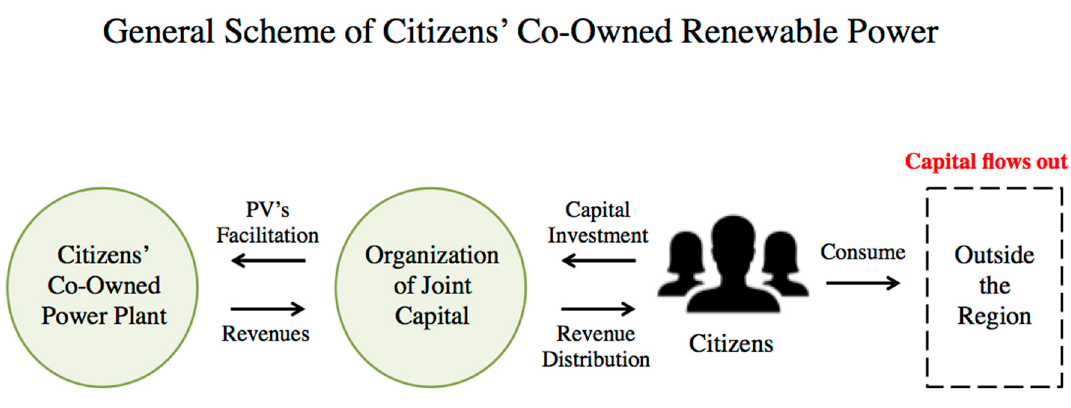
Figure 3. One possible weakness of the general Citizens’ Co-Owned Power Plants: “capital flows out of the region”. Source: modified from Hashimoto and Nakagawa [51].